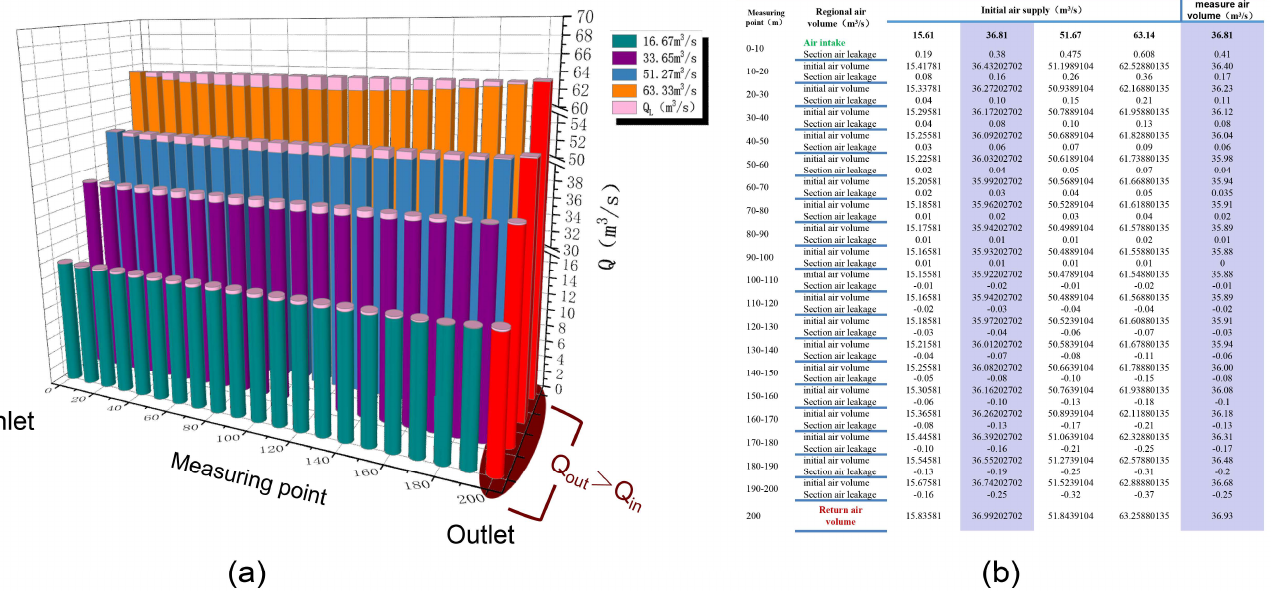
Figure 8. Temperature and gas concentration distribution diagram and data curve of different air volumes. ( a ) temperature distribution map; ( b ) gas concentration distribution map; ( c ) temperature and gas concentration curve; ( d ) turbulent kinetic energy and velocity curve; (1) L = 2; (2) L = 5; (3) L = 8; (4) L = 10.